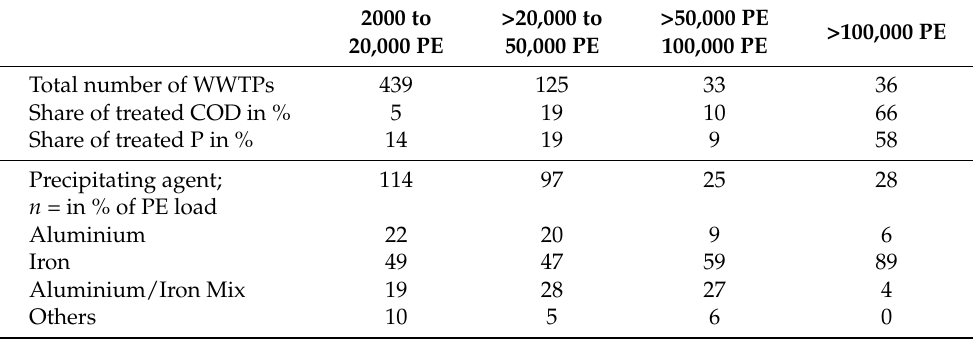
Table 2. Share of treated COD and P, and distribution of precipitating agents according to the size class of WWTPs in percent of population equivalent (PE)